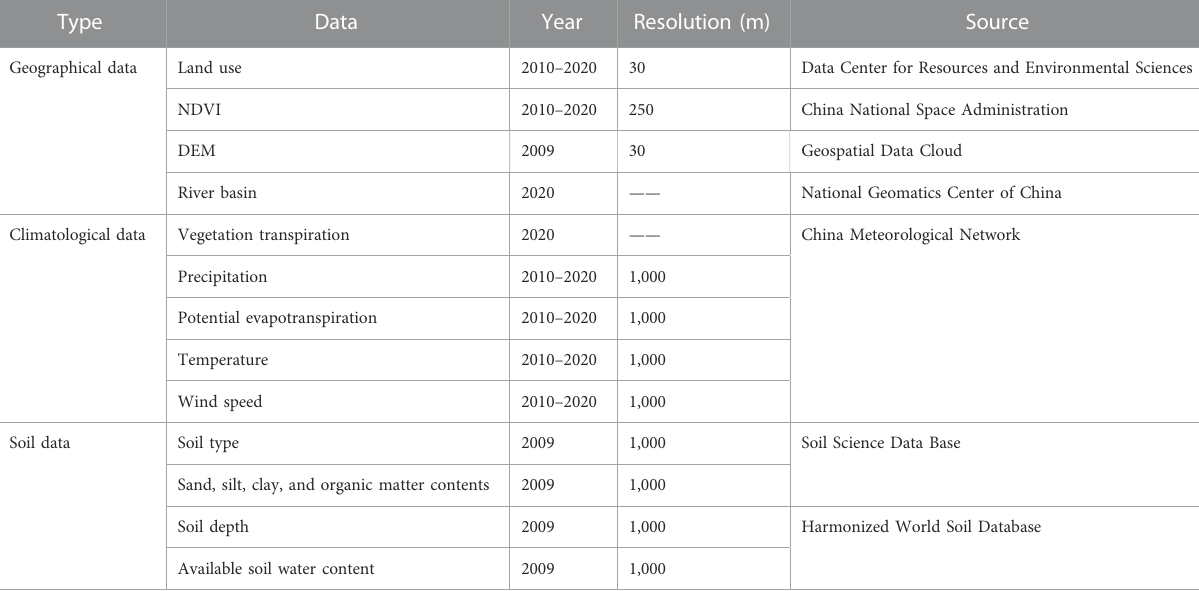
TABLE 1 Data sources used in this